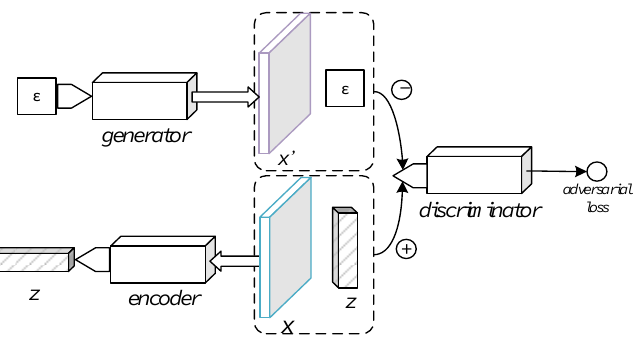
Figure 3. Diagram of the bidirectional generative adversarial network